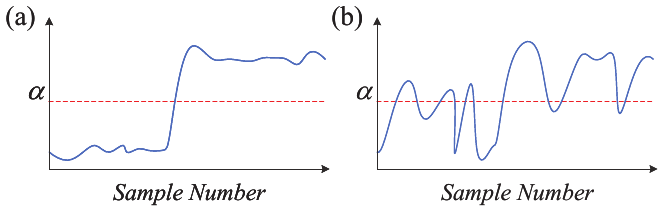
Figure 4. Illustration of the effects of noise and outliers in process monitoring. ( a ) is the training data without noise and outliers; ( b ) is the training data containing noise and